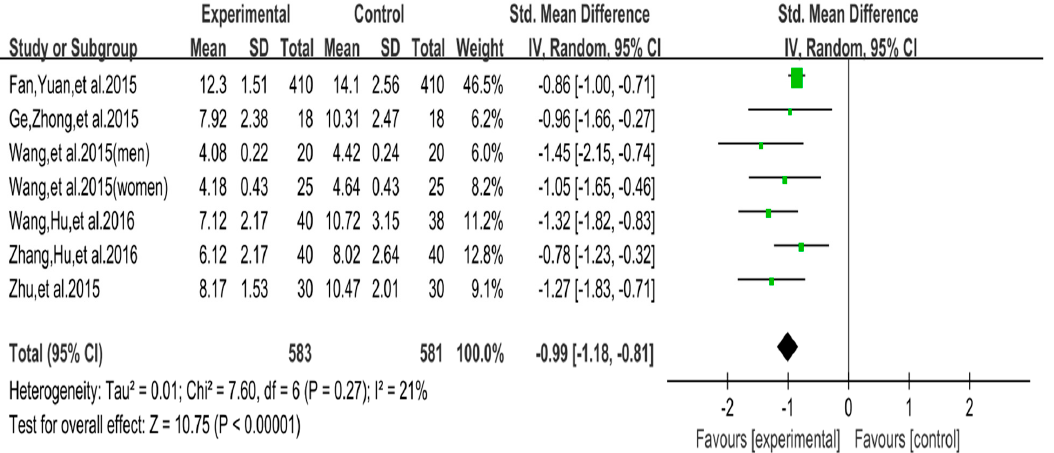
Figure 9. Effect of exercises on social comfort.